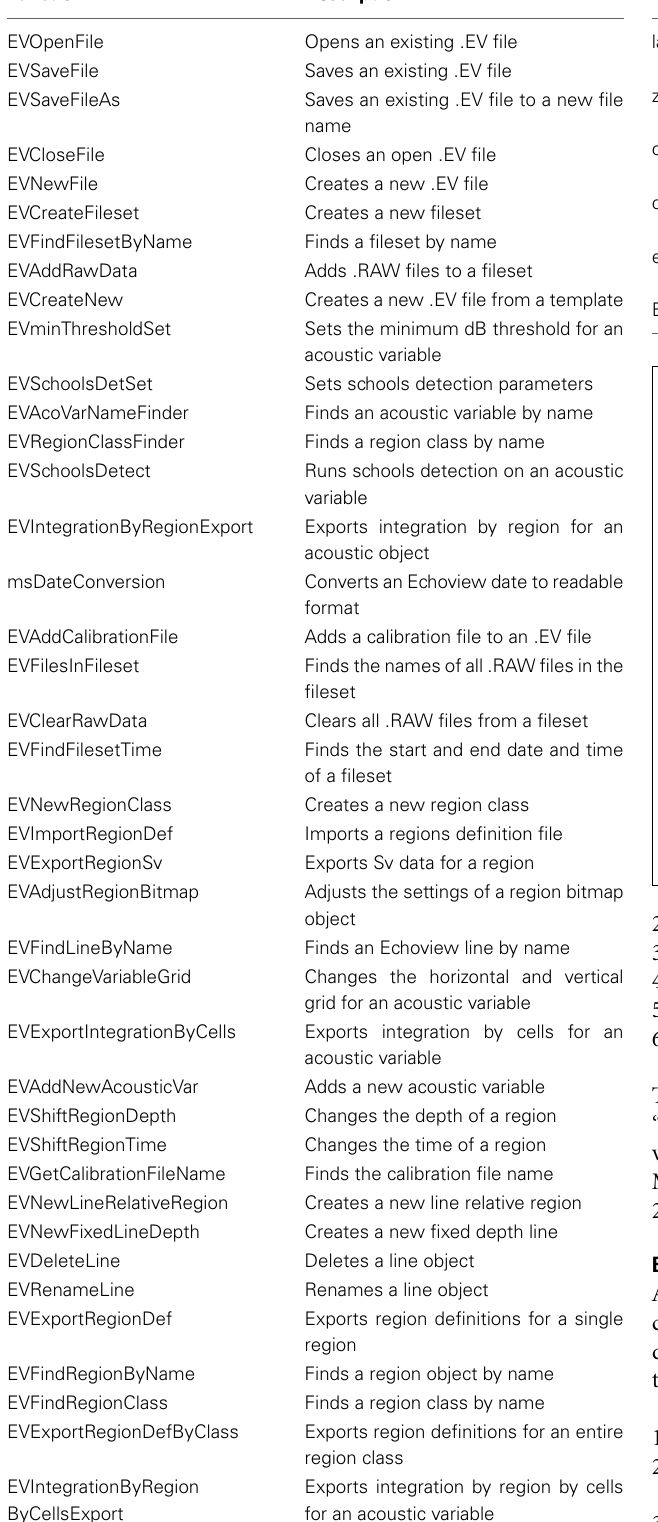
Table 1 | Functions available in EchoviewR. Function